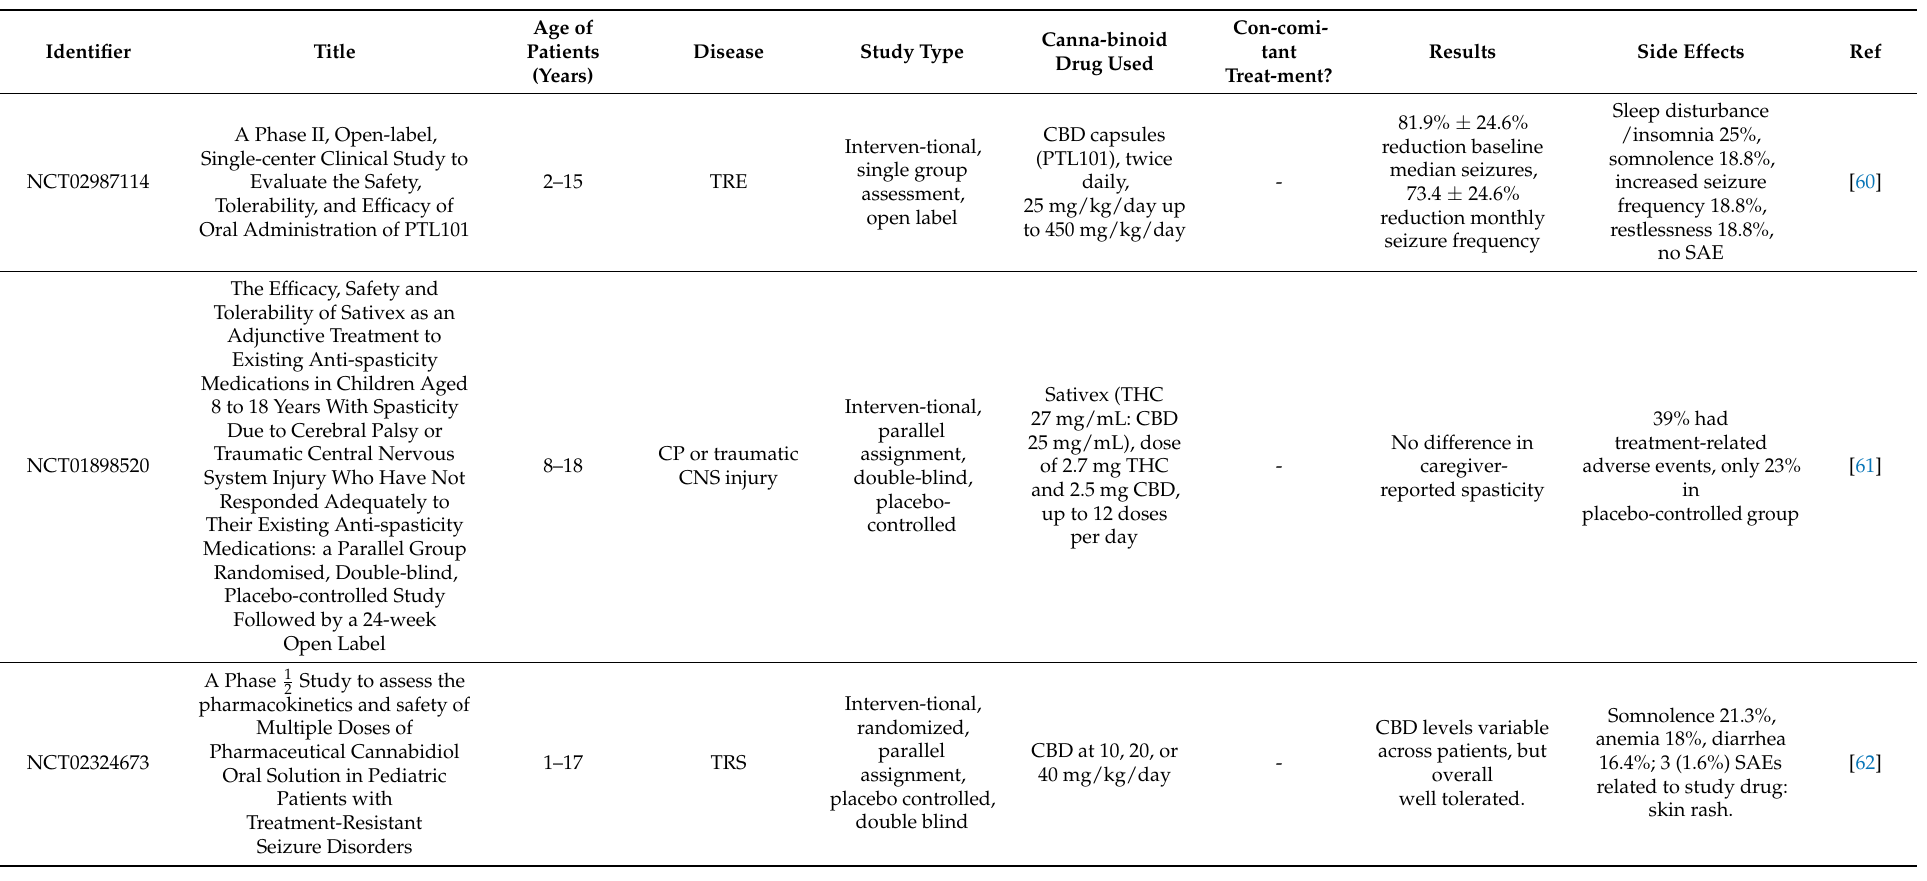
Table 1. Summary of published clinical trials involving pediatric patients and some form of cannabinoid